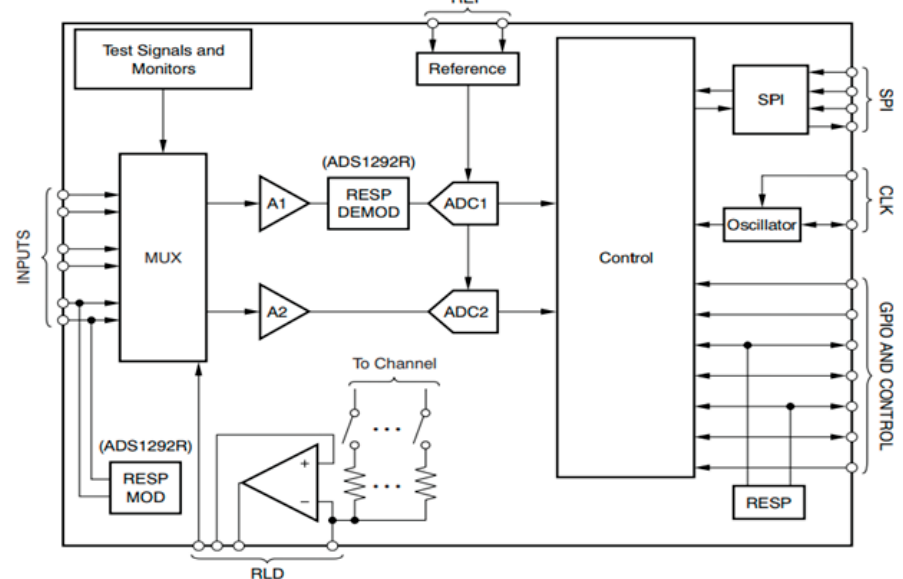
Figure 2. Block diagram of the ADS1292R chip. ADC: Analog to Digit Converter, RESPMOD: